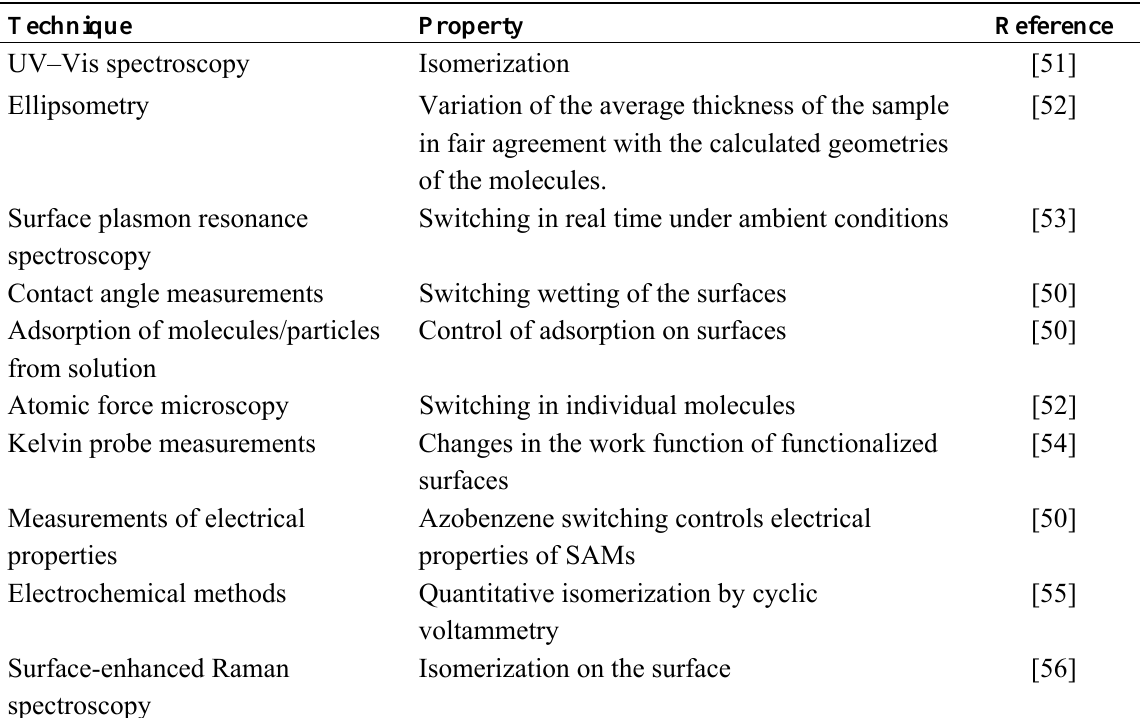
Table 1. A list of some techniques used to monitor morphology and property changes due to